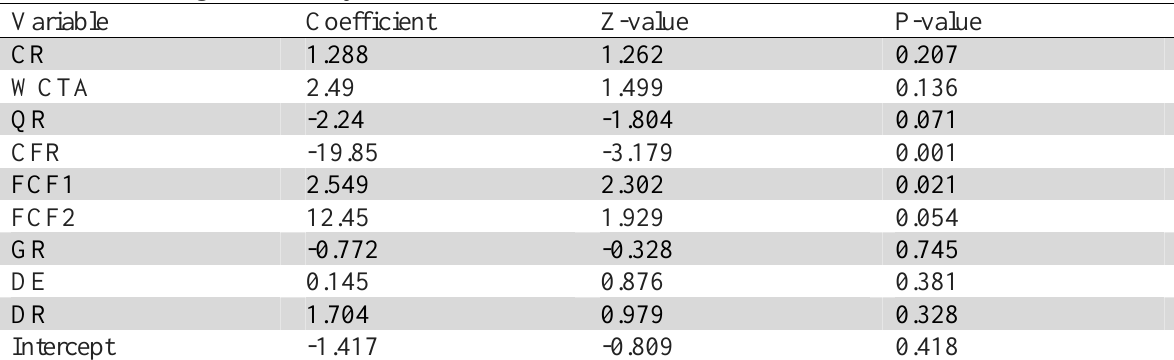
The results of regression